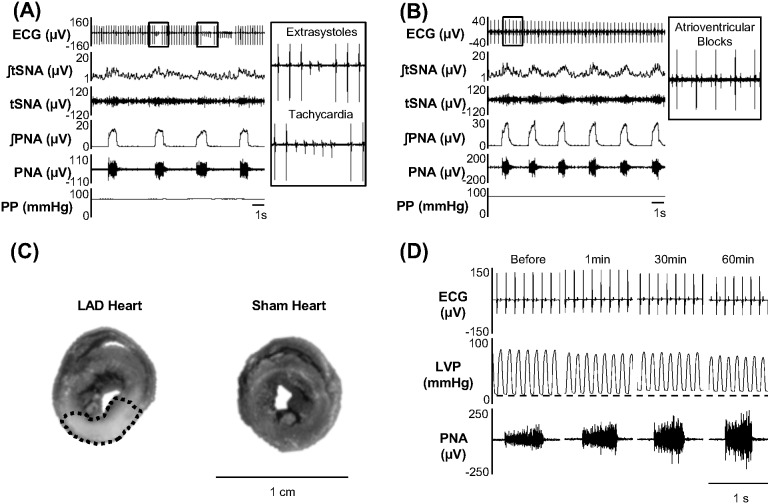
Representative traces from rats showing LVP and transient ECG changes post LAD ligation.(A) Extra-systoles and tachycardia occurred post LAD ligation in some rats. (B) Atrioventricular block starting shortly post LAD ligation. These changes in the ECG lasted 34.0±4.6 min. (C) Median cross-sections of Evans blue dye-stained hearts. The LAD heart cross-section (left) had a safe blue-marked area versus a myocardial area at risk that did not absorb the dye (outlined pale area), contrasting with the Sham heart completely stained blue. (D) Recording showing LVP before and 1, 30, and 60 min post LAD ligation.